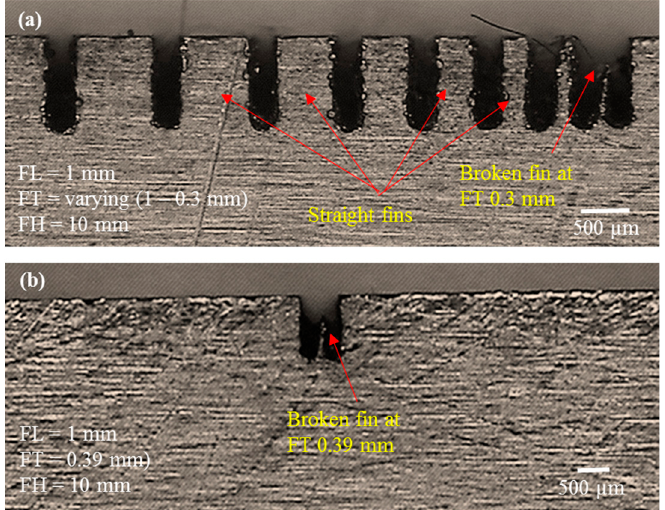
Figure 6. Microscopic analysis of structure traits in the first phase of experimentation. ( a ) fins with varying thickness but with constant length and height; ( b ) broken fin with thickness less than 0.4 mm.